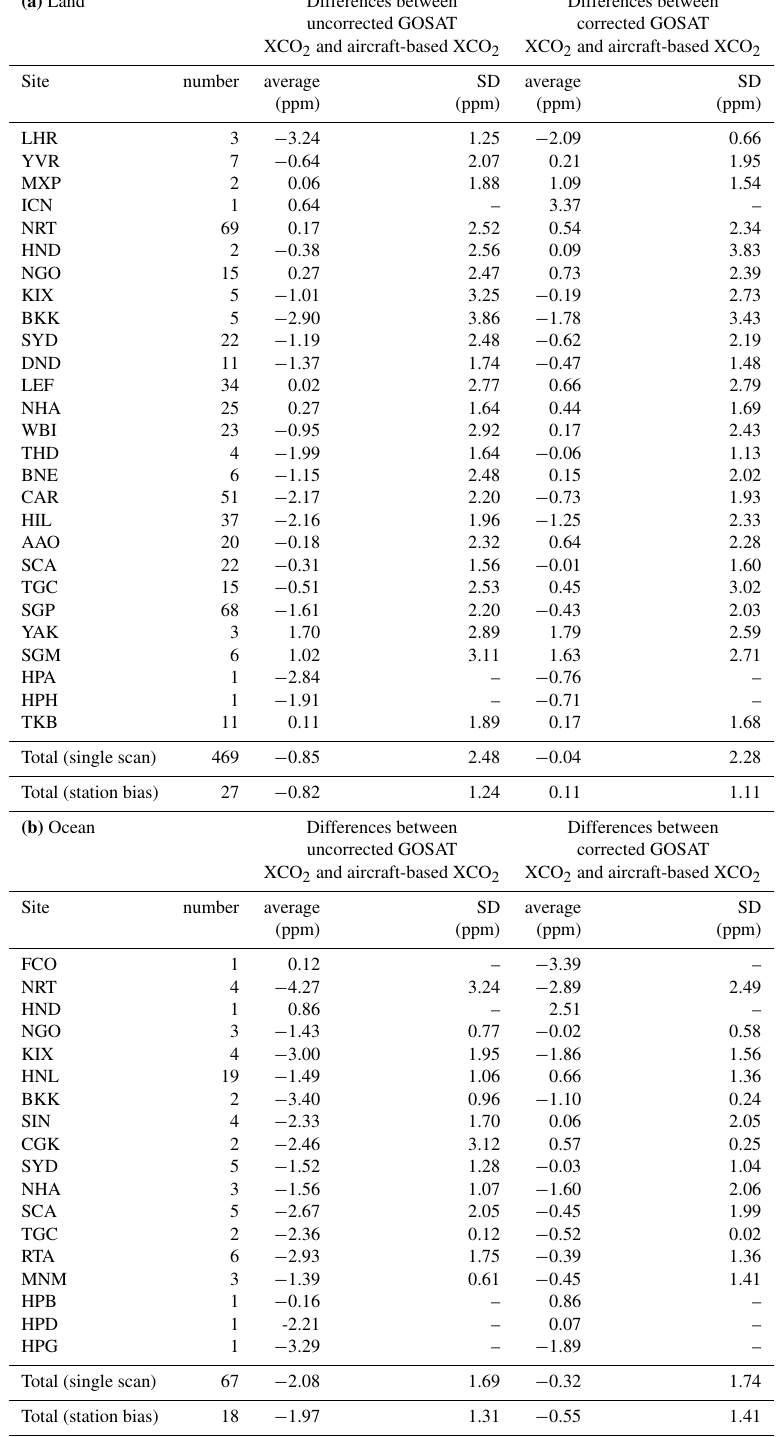
Table 6. The average and standard deviation of the differences between uncorrected/corrected GOSAT XCO 2 and aircraft-based XCO 2 at each aircraft observation site. The GOSAT data were retrieved over (a) land and (b) ocean regions within ± 5 ◦ latitude/longitude boxes centered at each site. The averages and standard deviations of the differences of the matched data at all aircraft observation sites (single scan) and those of the station biases are also shown in the second row from the bottom and the bottom row of the table,